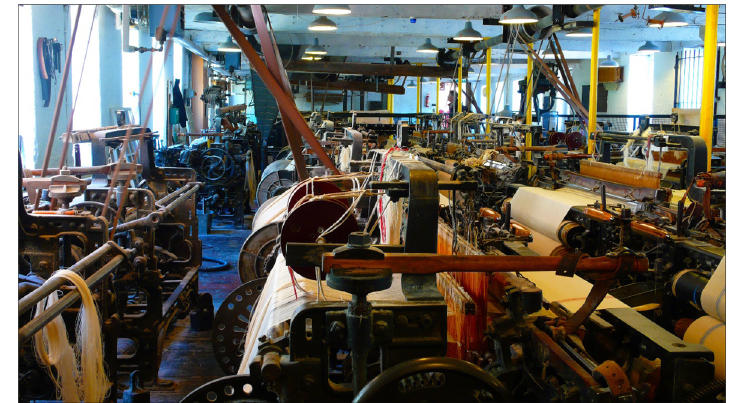
Fig. 11 Looms, Quarry Bank Mill,